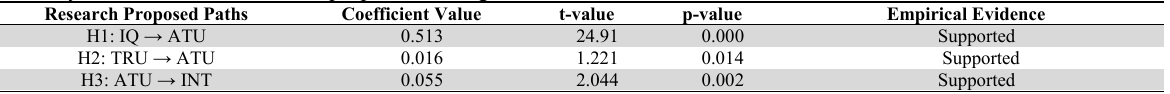
Summary of the theoretical model's proposed findings Research Proposed